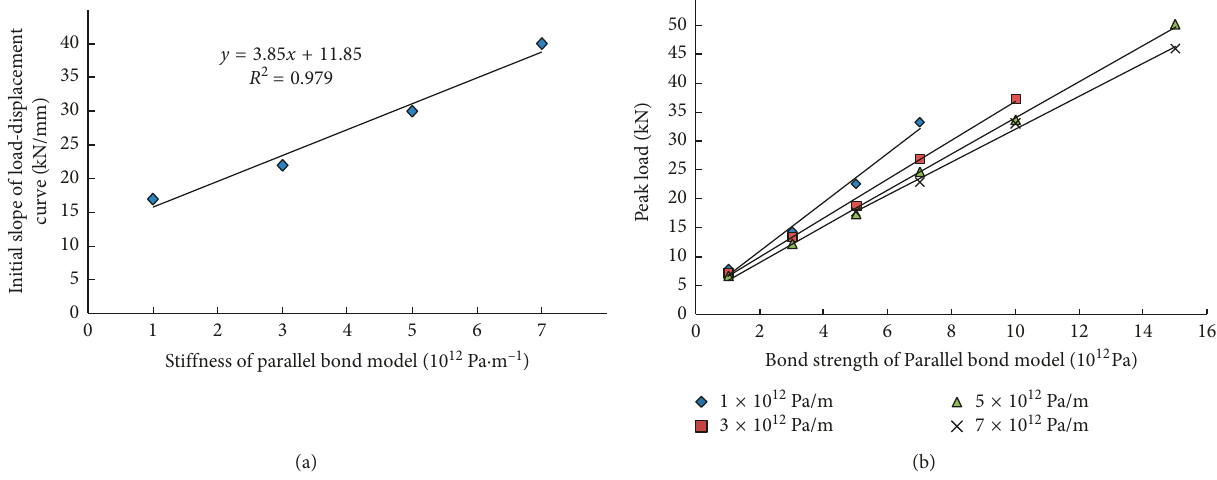
Figure 14: Parameters of the 3D parallel bond model. (a) Original slope of the splitting test curve versus stiffness. (b) Peak load of the splitting test versus bond strength. Table 2: Discrete bond model parameters of